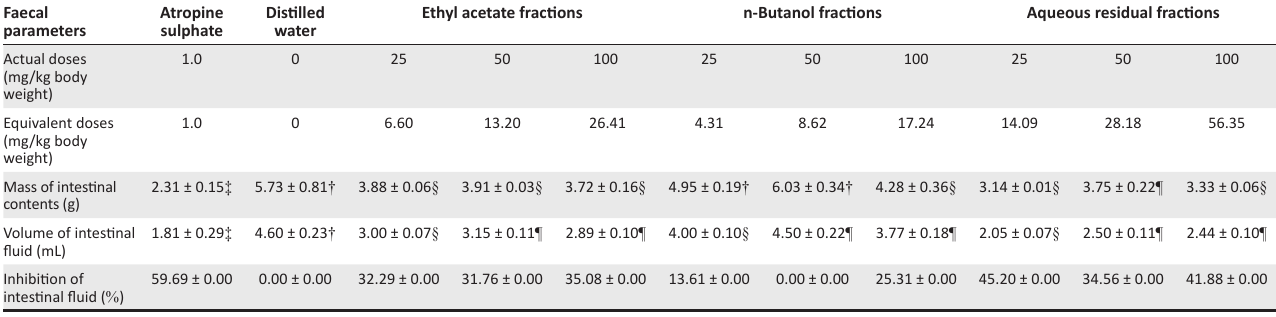
TABLE 2: Effects of the solvent–solvent fractions of aqueous extract of Mangifera indica leaves on castor oil-induced enteropooling in female Wistar rats. Faecal Atropine Distilled parameters sulphate water